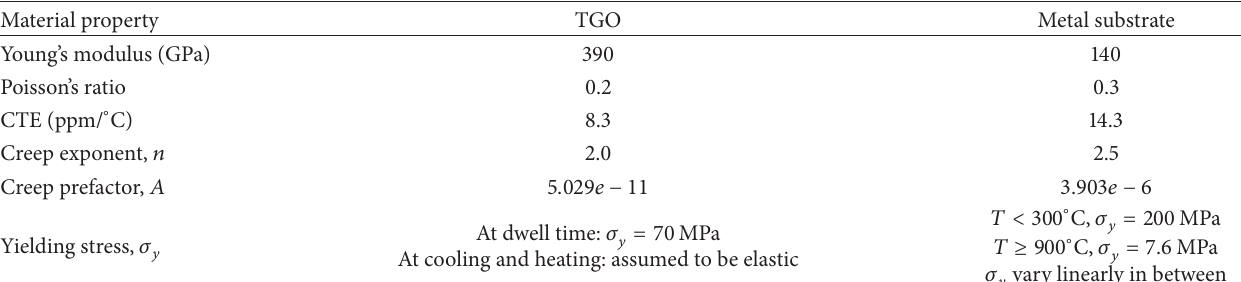
Table 1: Material properties for TGO and metal